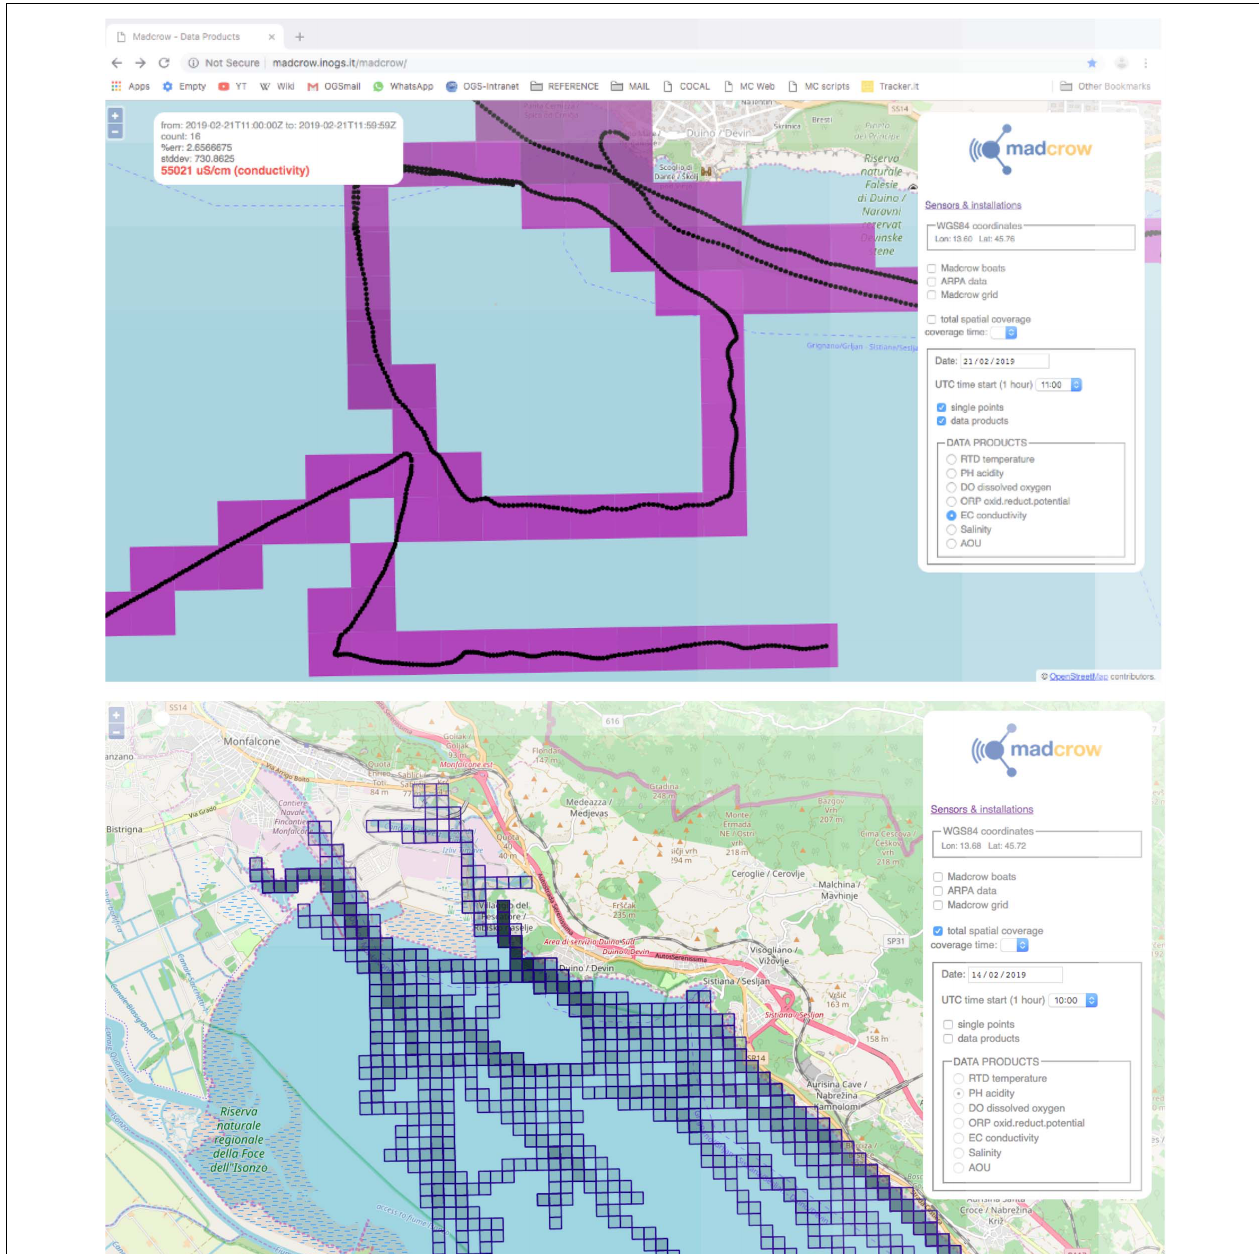
FIGURE 9 | Coverage of the processed data and Geographic distribution of a single parameter (Conductivity) as can be seen for the pilot web portal of the MaDCrow Project. The portal allows to retrieve single measurements, aggregate gridded data and details for a single